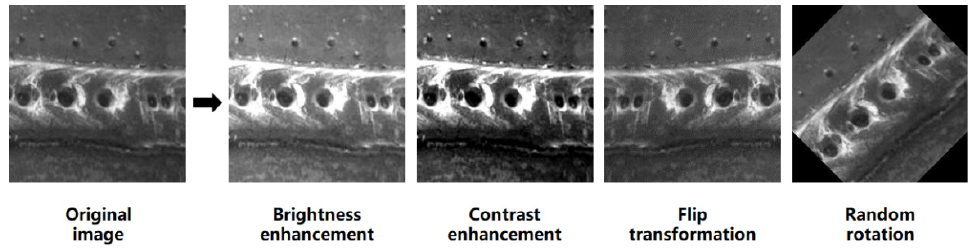
Figure 2. Sample images in the self-built dataset (partial).